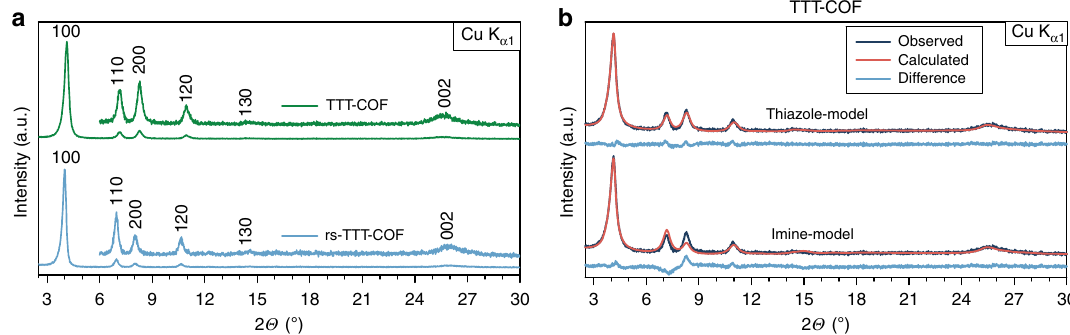
Fig. 3 XRPD and modeling of the TTI- and TTT-COF. a XRPD patterns of the rs-TTI-COF and the TTT-COF showing retention of crystallinity upon transformation. b Comparison of the imine and thiazole models that were applied during Rietveld re fi nement of the XRPD TTT-COF. The thiazole model (top) shows a better fi t than the imine model (bottom) reduced in-plane unit cell dimensions (24.478(5) Å vs 25.244(8) Å), and a larger interlayer stacking distance ( c = 7.002(5) Å) than rs-TTI-COF ( c = 6.905(7) Å) as is evident from Rietveld re fi ne-